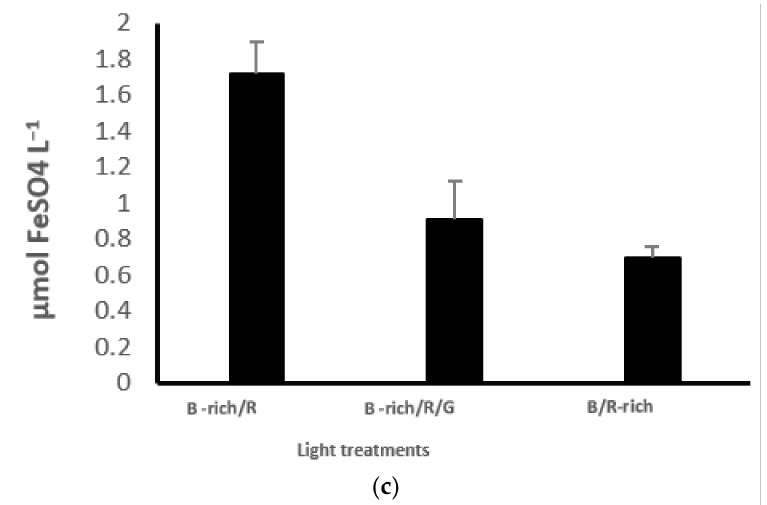
Figure 3. Antioxidant activities in lettuce at second harvest under different LEDs treatments; ( a ) effects of high intensity of B345/R, B450/R and B/R-rich: LSD of treatments = no significance ( p = 0.296). ( b ) Effects of low intensity of B345/R, B450/Rand B/R-rich: LSD treatments = 0.60 ( p = 0). ( c ) Effects of B-rich/R, B-rich/R/G and B/R-rich; LSD treatments 0.41 ( p =